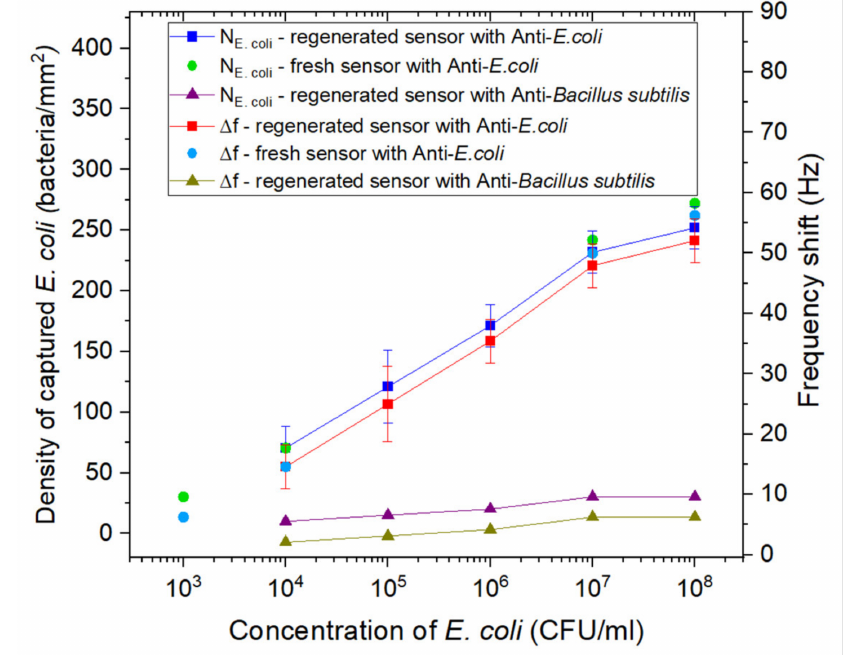
Figure 8. Surface density of captured E. coli (left y -axis) and frequency shifts (right y -axis) reported after exposure to increasing concentrations of E. coli : fresh sensor samples functionalized with E. coli antibodies (circles), regenerated sensor samples functionalized with B. subtilis antibodies (triangles), and regenerated sensor samples functionalized with E. coli antibodies (squares). The E. coli suspensions were prepared in PBS